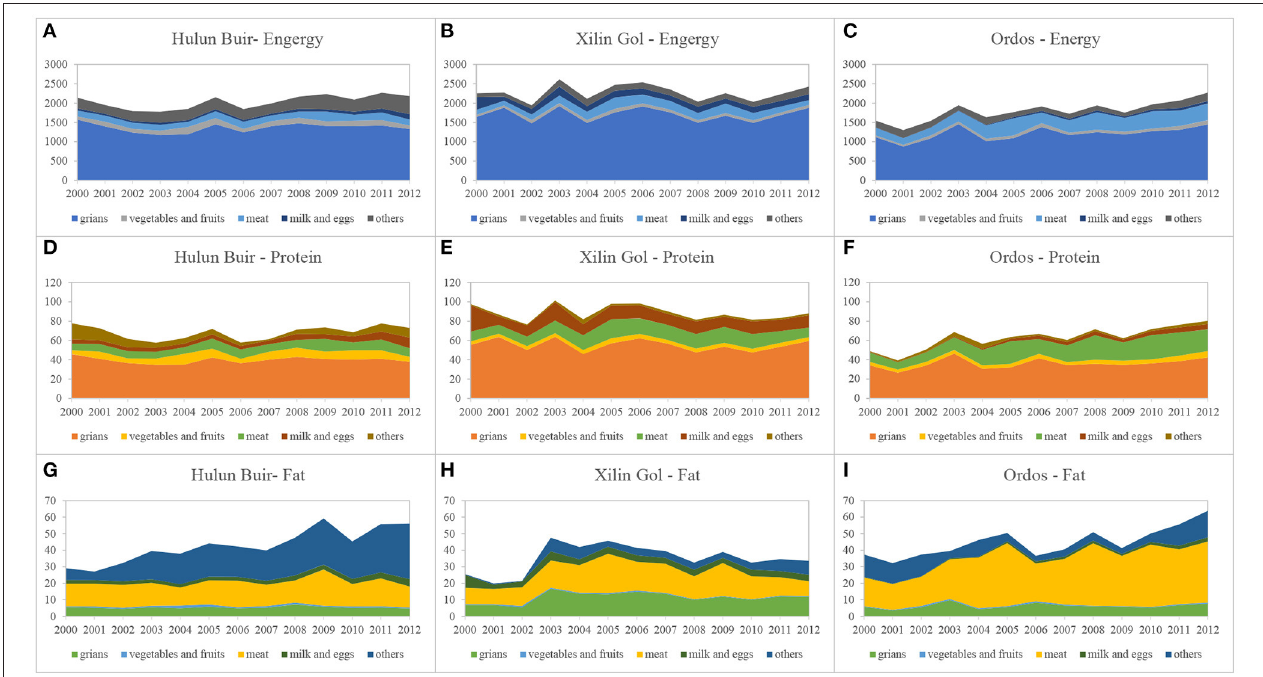
TABLE 7 | NPP, NDVI, grassland, and cropland areas of the three study sites (2000–2012 averages). Factor one-way ANOVA Hulun Buir Xilin Gol Ordos F p -value Mean Variance Mean Variance Mean Variance NPP (gC/m 2 yr) 177.85 <0.001*** 299.16 a 791.54 191.44 b 374.51 129.96 c 318.68 NDVI